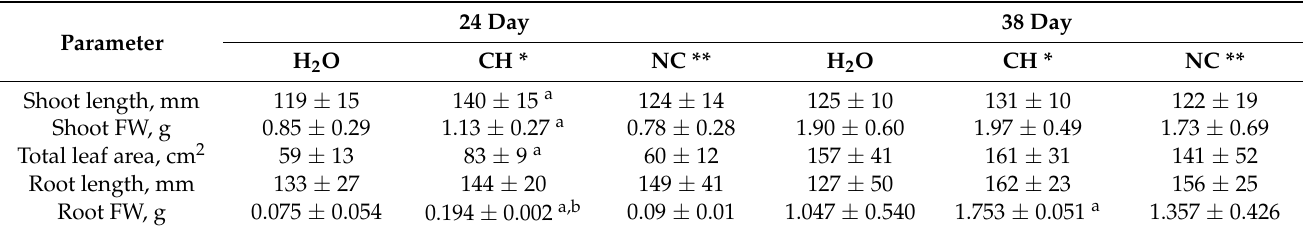
Table 1. Effects of CH, NC, and H 2 O on shoot and root FW, shoot and root length, and total leaf area of the lettuce plants at the 24th and 38th